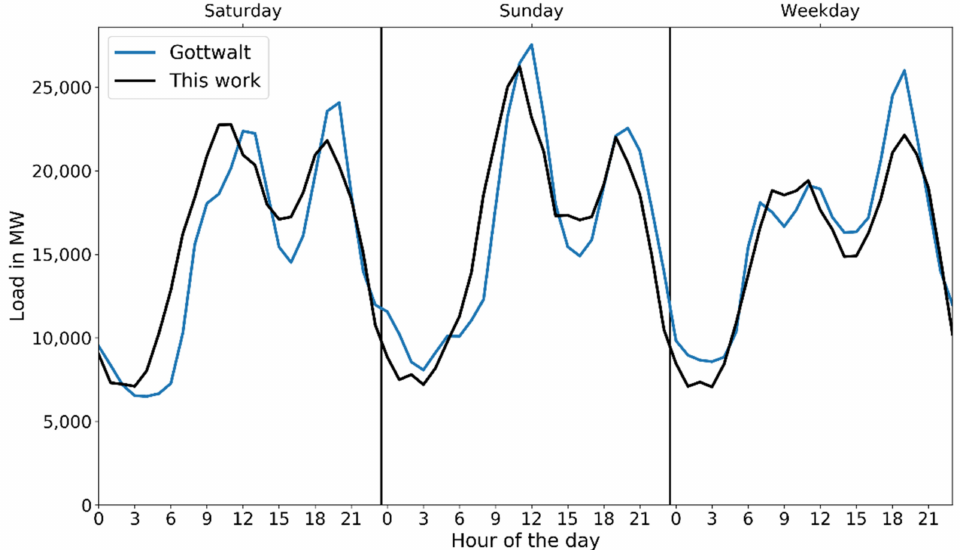
Figure A10. Comparison of the daily average load curve in Germany between this work and data reproduced from [8], Gottwalt et al.: 2011. Values are grouped by the hour of the day and the type of weekday and are scaled to the same annual consumption. The X-axis shows local